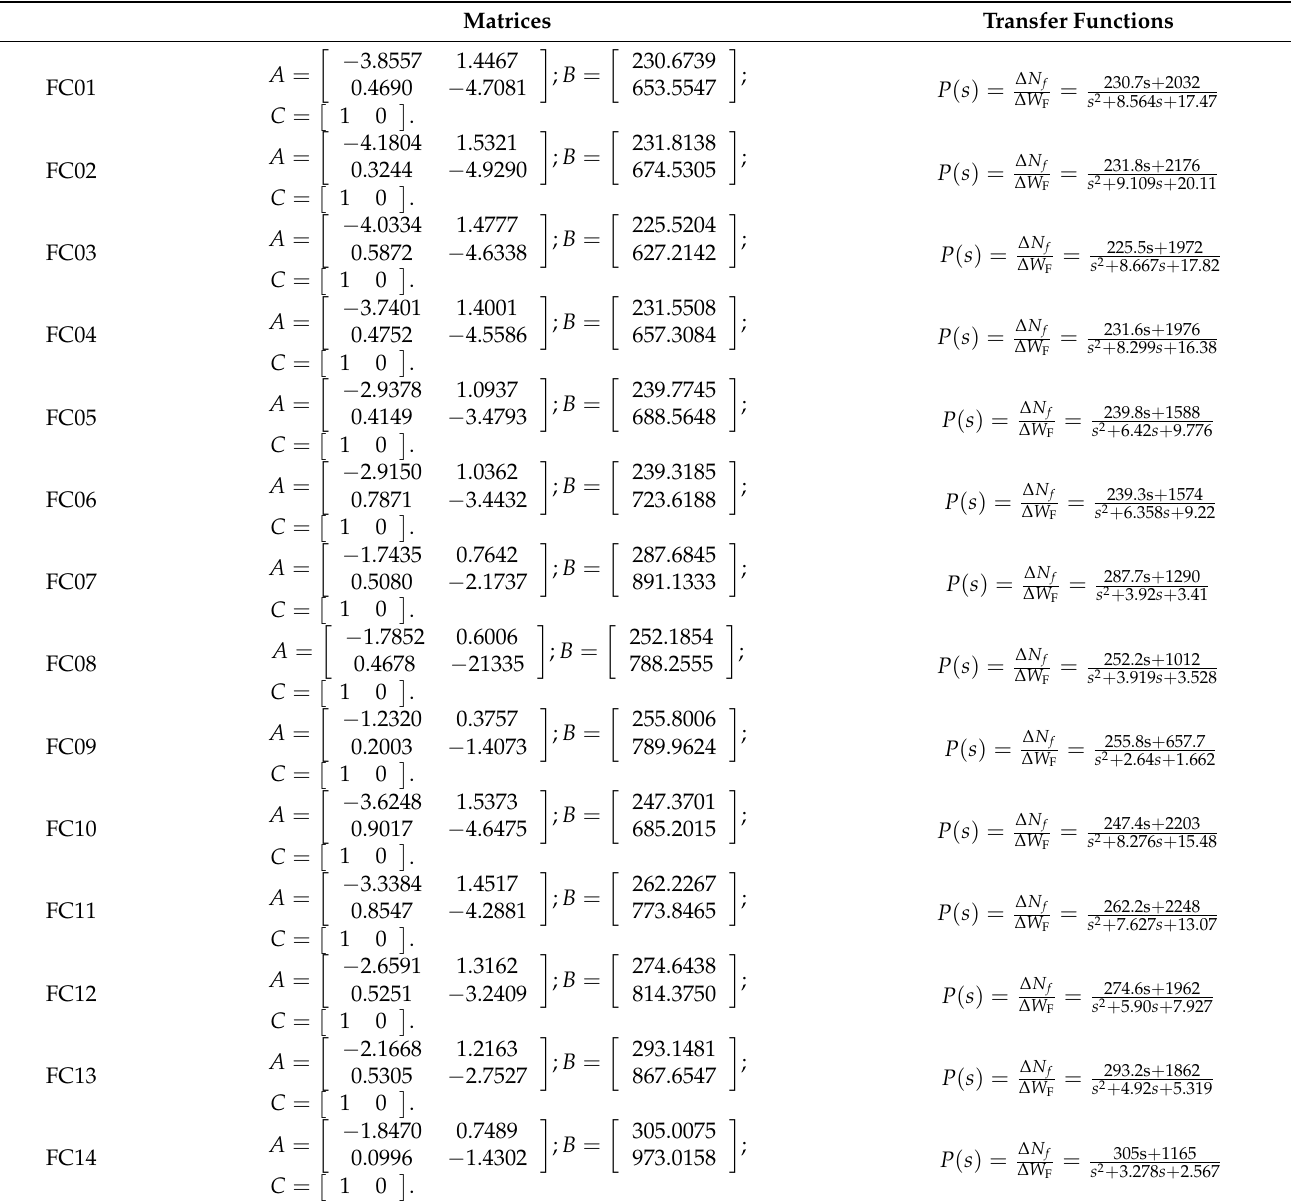
Table A2. The matrices and transfer functions of 14 flight